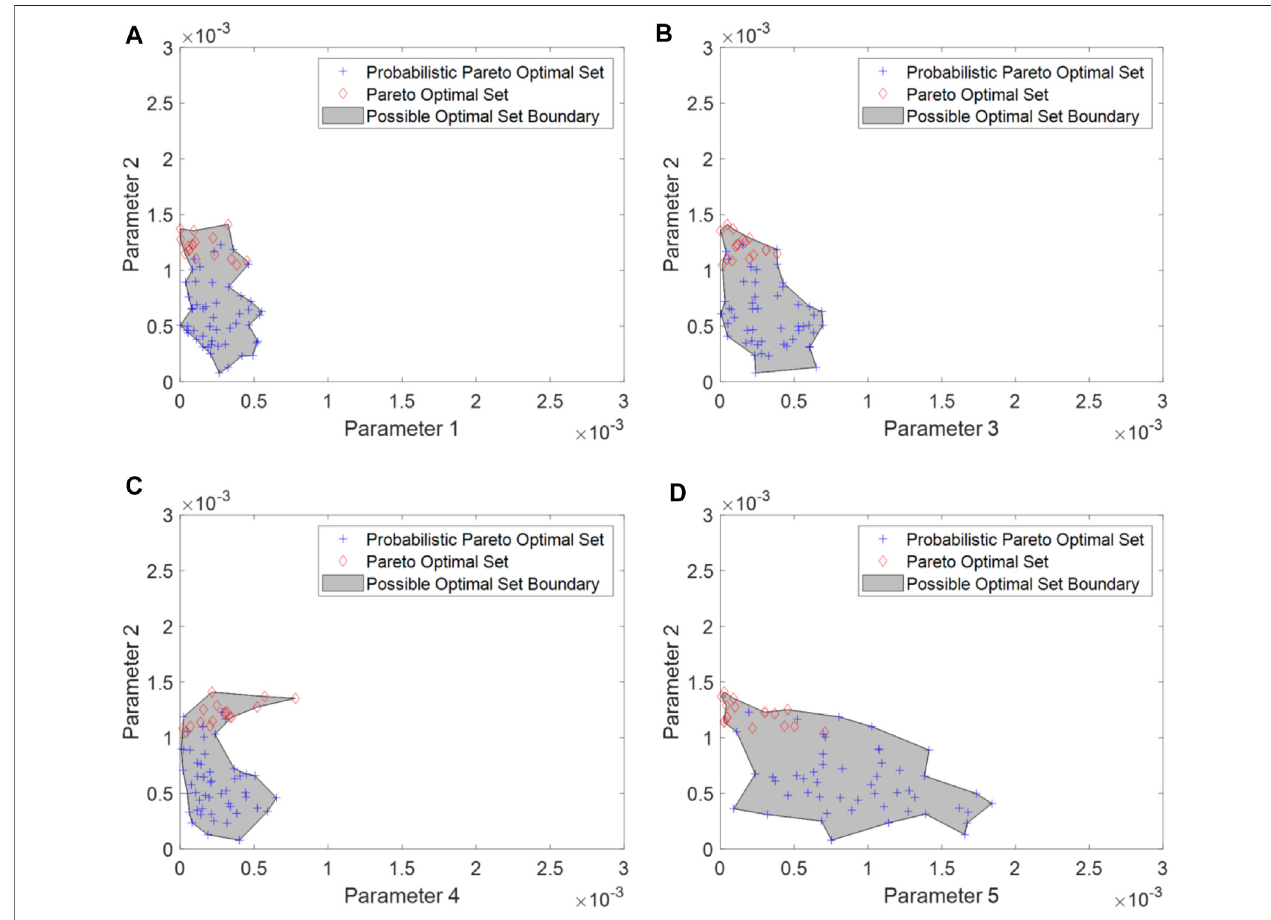
FIGURE 12 | Two-dimensional illustration of the probabilistic Pareto optimal set. (A) Parameter 1 versus Parameter 4; (B) Parameter 2 versus Parameter 4; (C) Parameter 3 versus Parameter 4; and (D) Parameter 5 versus Parameter 4 (case 2).